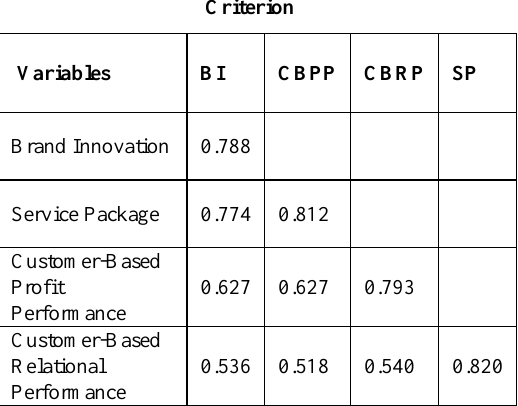
Table 2: Discriminant Validity: Fornell and Larcker Criterion